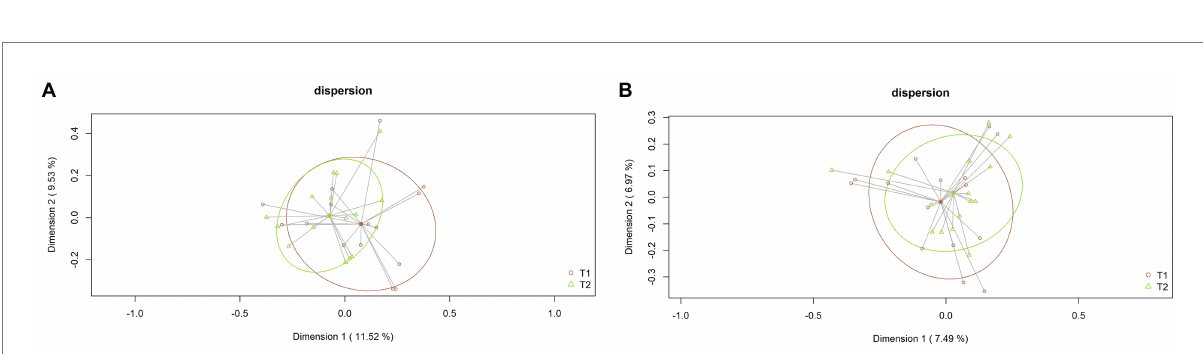
FIGURE 4 Beta diversity at the ASV level of the fecal samples obtained at day 0 (T1) and at day 120 (T2). (A) PCoA plots based on the Bray–Curtis dissimilarity index (relative abundance); (B) PCoA plots based on the Jaccard’s coefficient for binary data (presence of